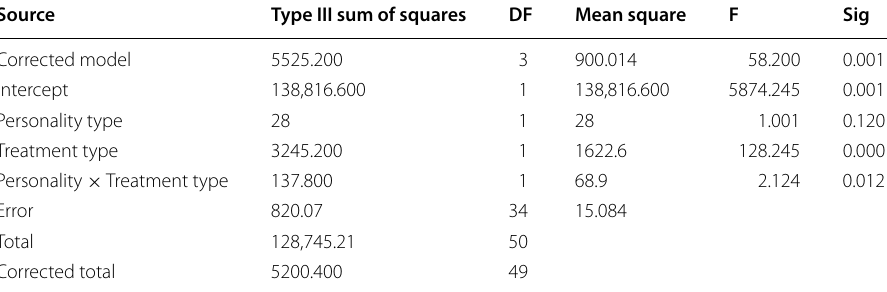
Table 5 Two-way ANOVA for the scores of the post-tests Source